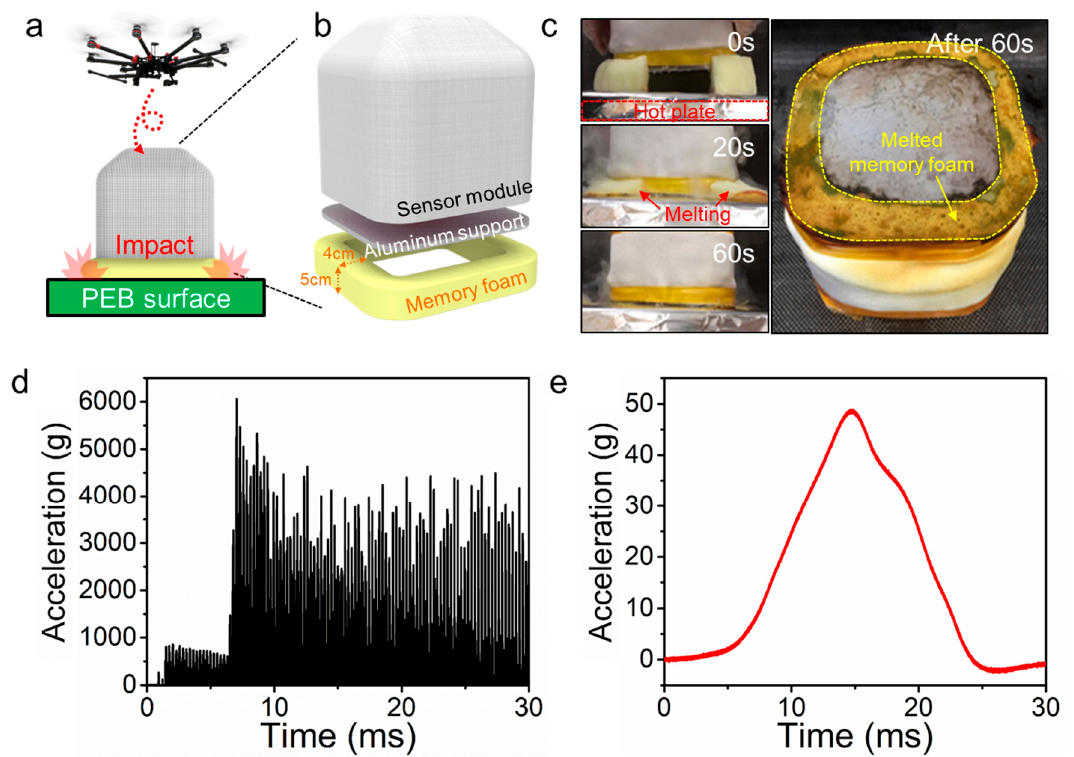
Figure 6. ( a ) Schematic depicting the shock absorbing and sensor deploying mechanism; ( b ) illustration of the installation location and size of the impact absorber; ( c ) glass transition of the memory foam layer on a 500-°C hot plate; ( d ) measured acceleration at the moment of impact without the memory foam cushion layer and e with the cushion layer.